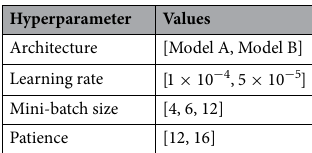
Table 1. List of hyperparameters that were randomly sampled from. See Supplementary Appendix A for the model